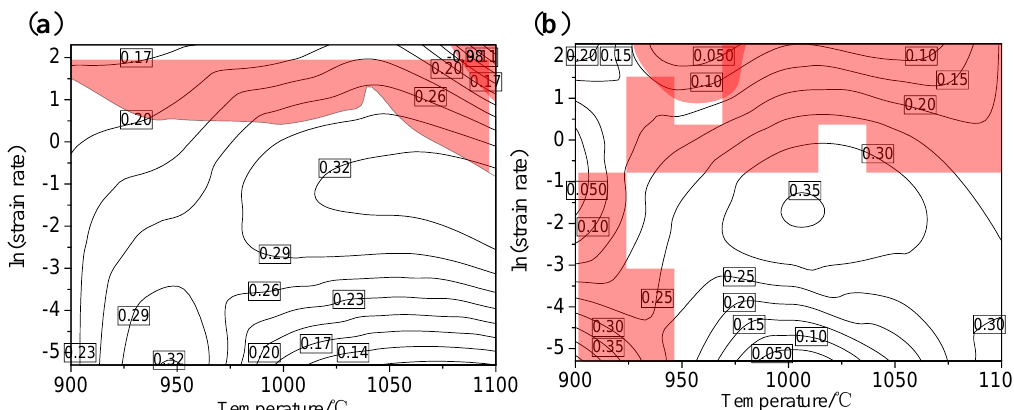
Figure 12. Processing maps of a high-titanium Nb-micro-alloyed steel obtained by superposition of the PDM and the instability map under true strains: ( a ) 0.6 and ( b ) 0.8.